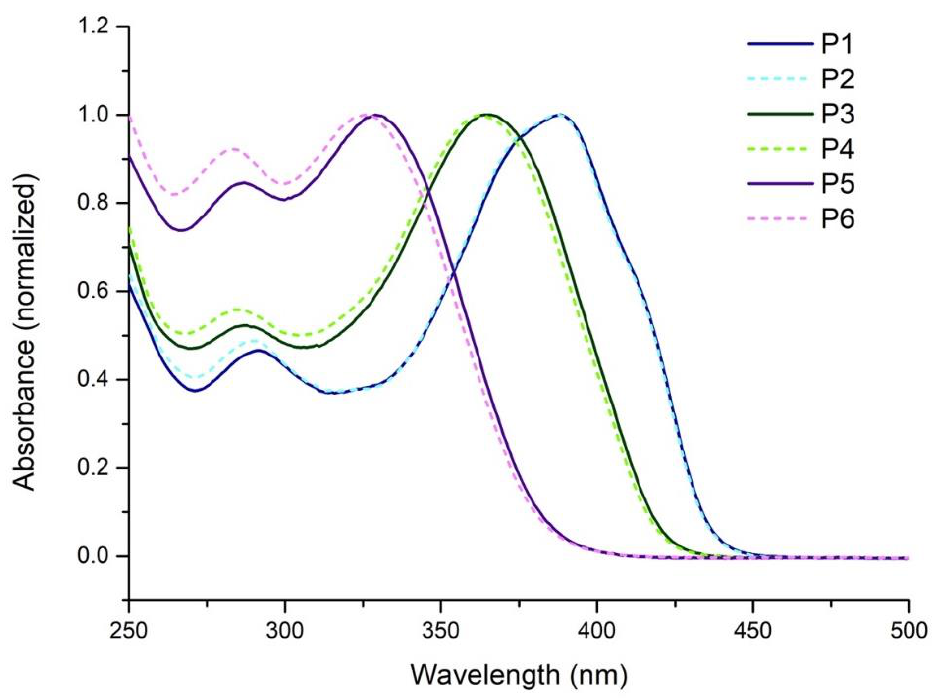
Figure 2. Absorbance spectra of polyazomethines in methylene chloride 10 − 2 g/L, soluble fraction for P6 ).